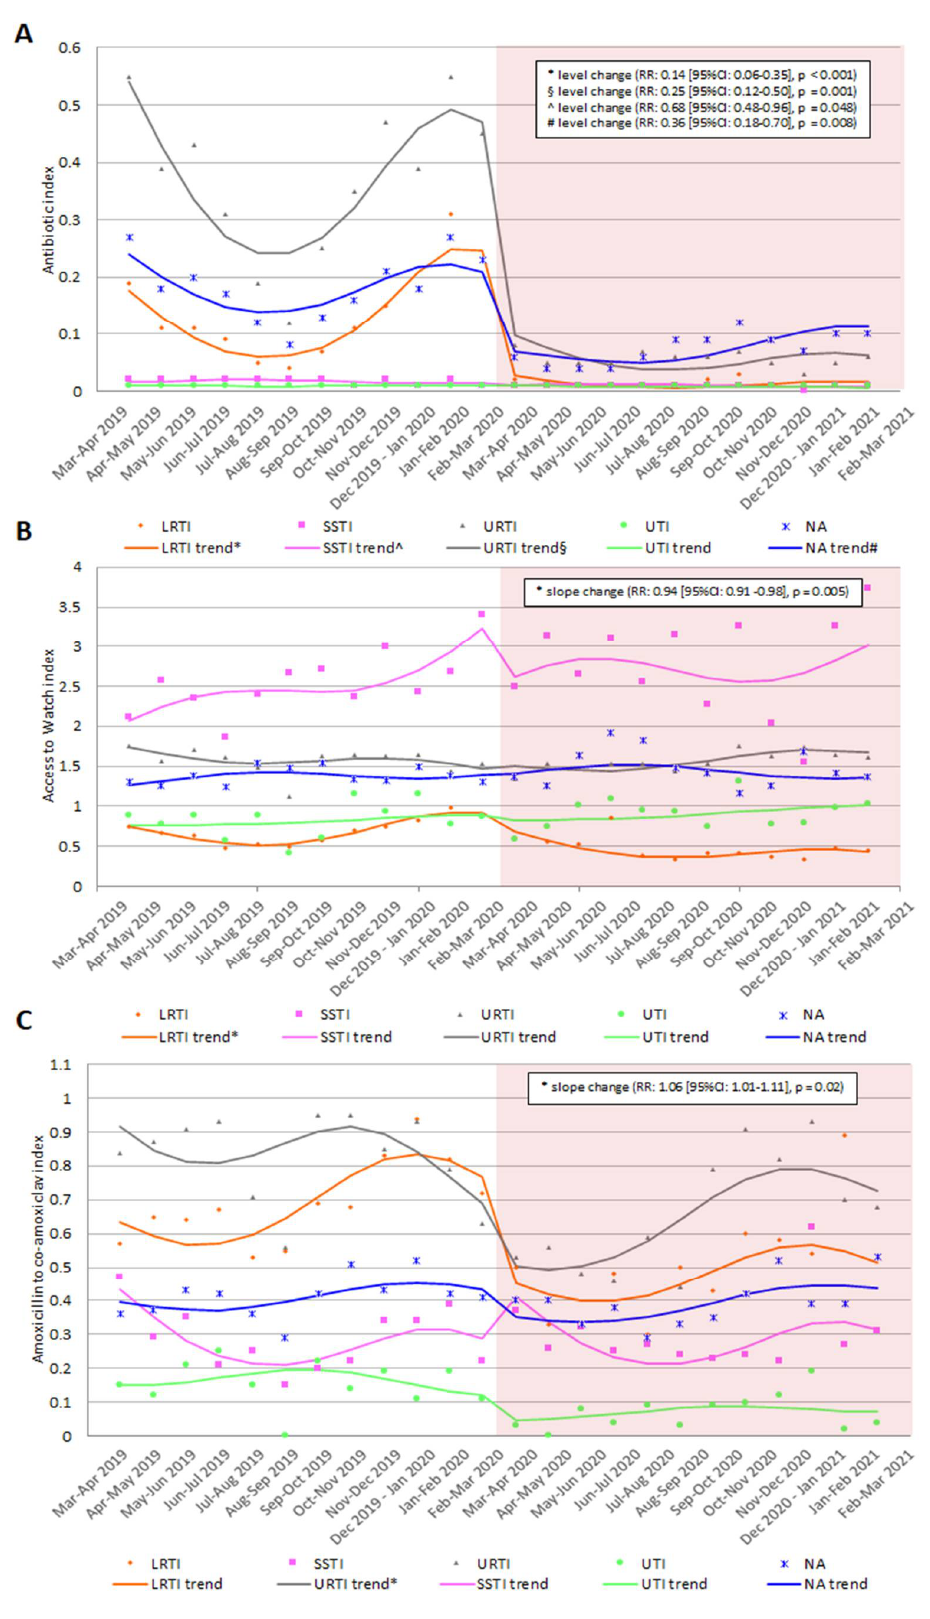
Figure 3. Antibiotic index ( A ), Access to Watch index ( B ), and amoxicillin to co-amoxiclav index ( C ) in children 0–14 years of age in Italy in the 12 months before and after COVID-19 containment measures implementation by diagnosis class. Pedianet 2019–2021.